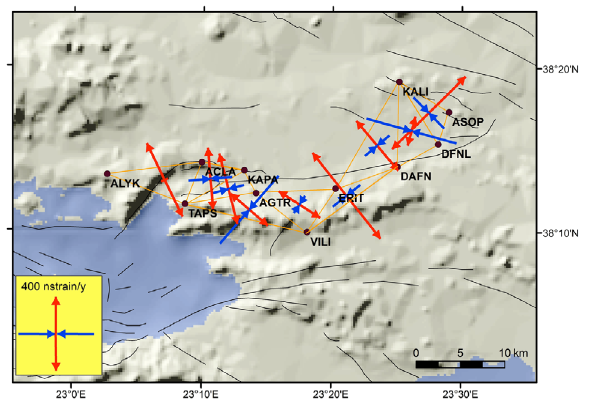
Figure 8. Strain tensors calculated inside station triangles for the eastern and western part of the area. Red arrows indicate exten- sion, blue arrows compression. Grey lines are active faults [Ganas et al.